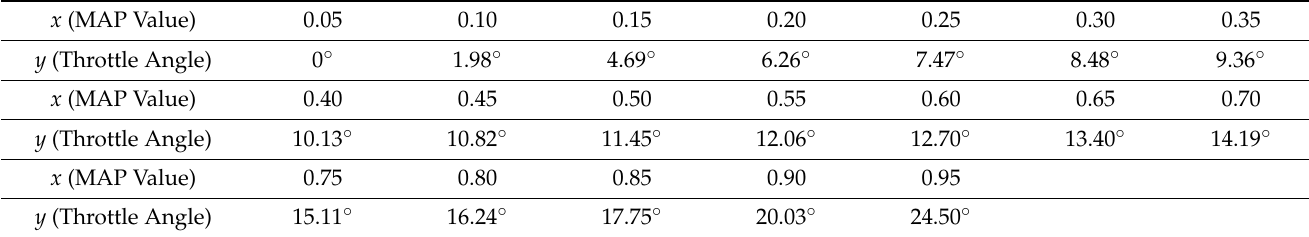
Table 6. MAP value ( x ) and throttle angles ( y ) at 300 r/min [27].